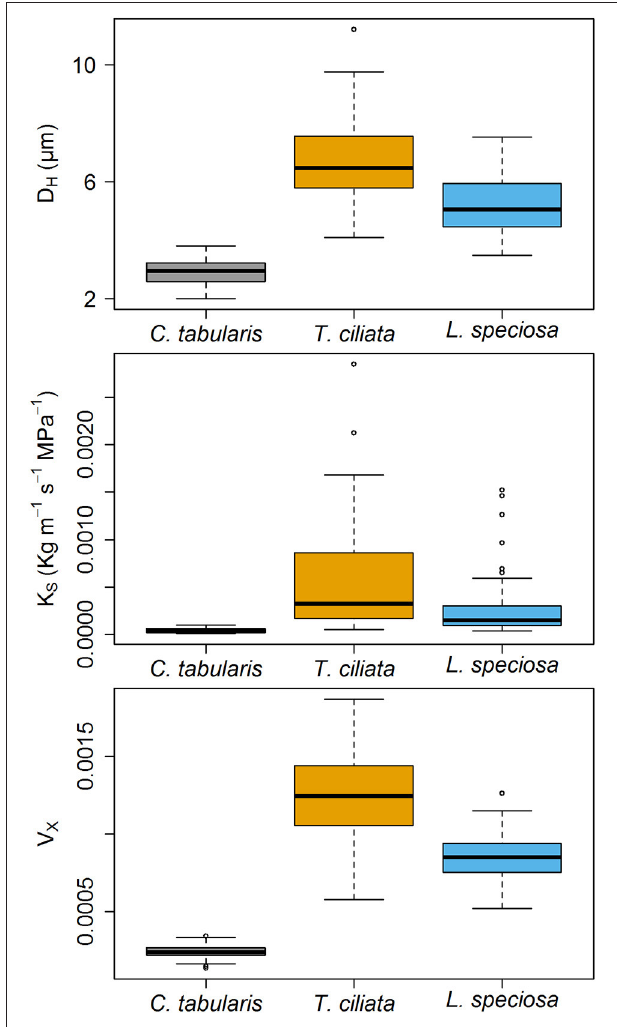
FIGURE 4 | Boxplots of Hagen–Poiseuille hydraulically weighted vessel diameter (D H ), Potential specific hydraulic conductivity (K S ) and vulnerability index (V X ) of three South Asian tropical moist forest tree species. Different letters indicate significant difference ( p < 0.01) among the